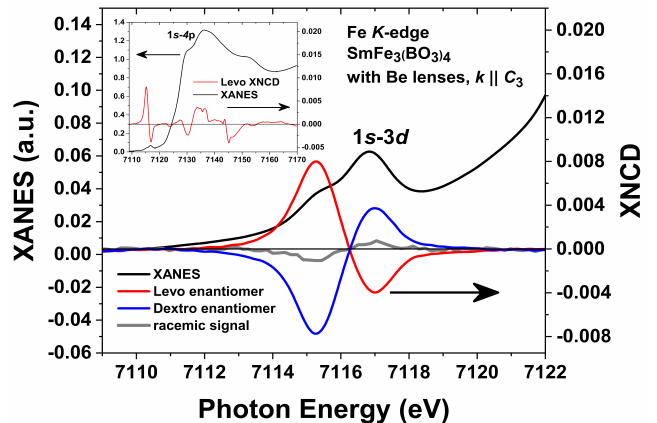
Figure 4. Experimental dichroism signals obtained from XANES experiments at the Fe K -edge for two enantiomorphous positions of the racemic SmFe 3 (BO 3 ) 4 single-crystal recorded with the X-ray wavevector parallel the trigonal c -axis: pre-edge XANES structures from 7112 eV to 7119 eV can be assigned to a set of 1 s –3 d transitions; near-edge structures to 1 s –4 p shape resonances. All spectra exhibit XNCD; the intensities of pre-edge peaks are anticorrelated, when a beam with circular polarization is moving on the surface of the crystal from one enantiomorphous domain to another, the peaks have maximum and minimum, respectively. XNCD signal for the racemic domain under a large beam of 300 microns is shown. On the inset: the black curve is the corresponding averaged XANES spectrum, and the red curve is the corresponding XNCD spectrum for one enantiomer extending to the whole measured energy